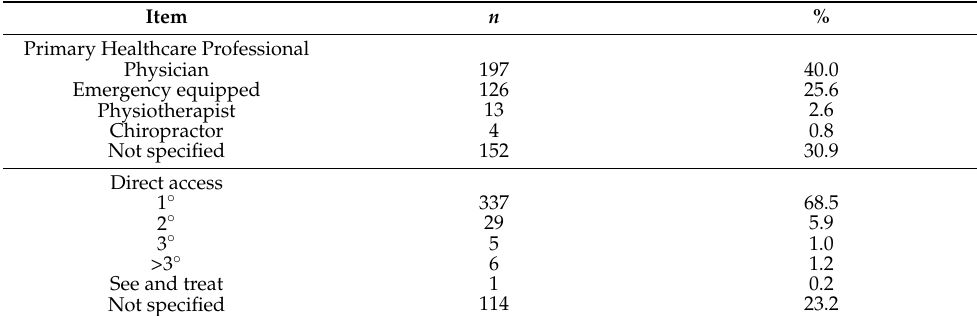
Table 3. Assessment by primary healthcare